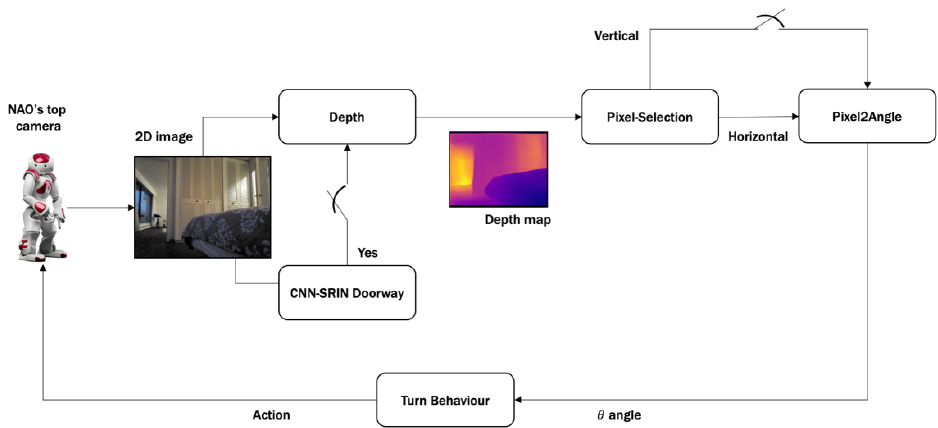
Figure 2. Our proposed robotic system for doorway detection and direction: 3Ds-system.